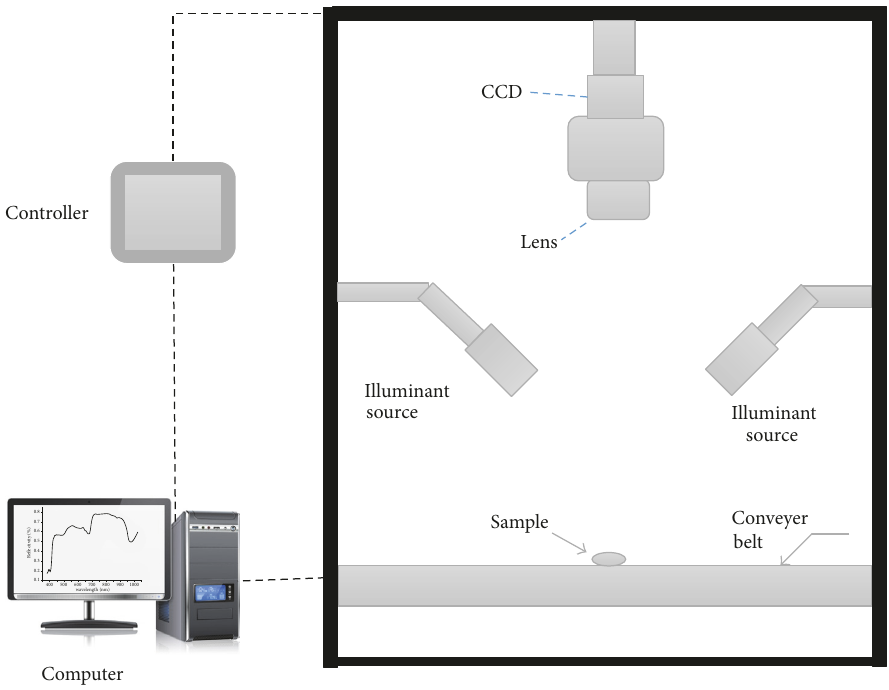
Figure 1: The hyperspectral imaging